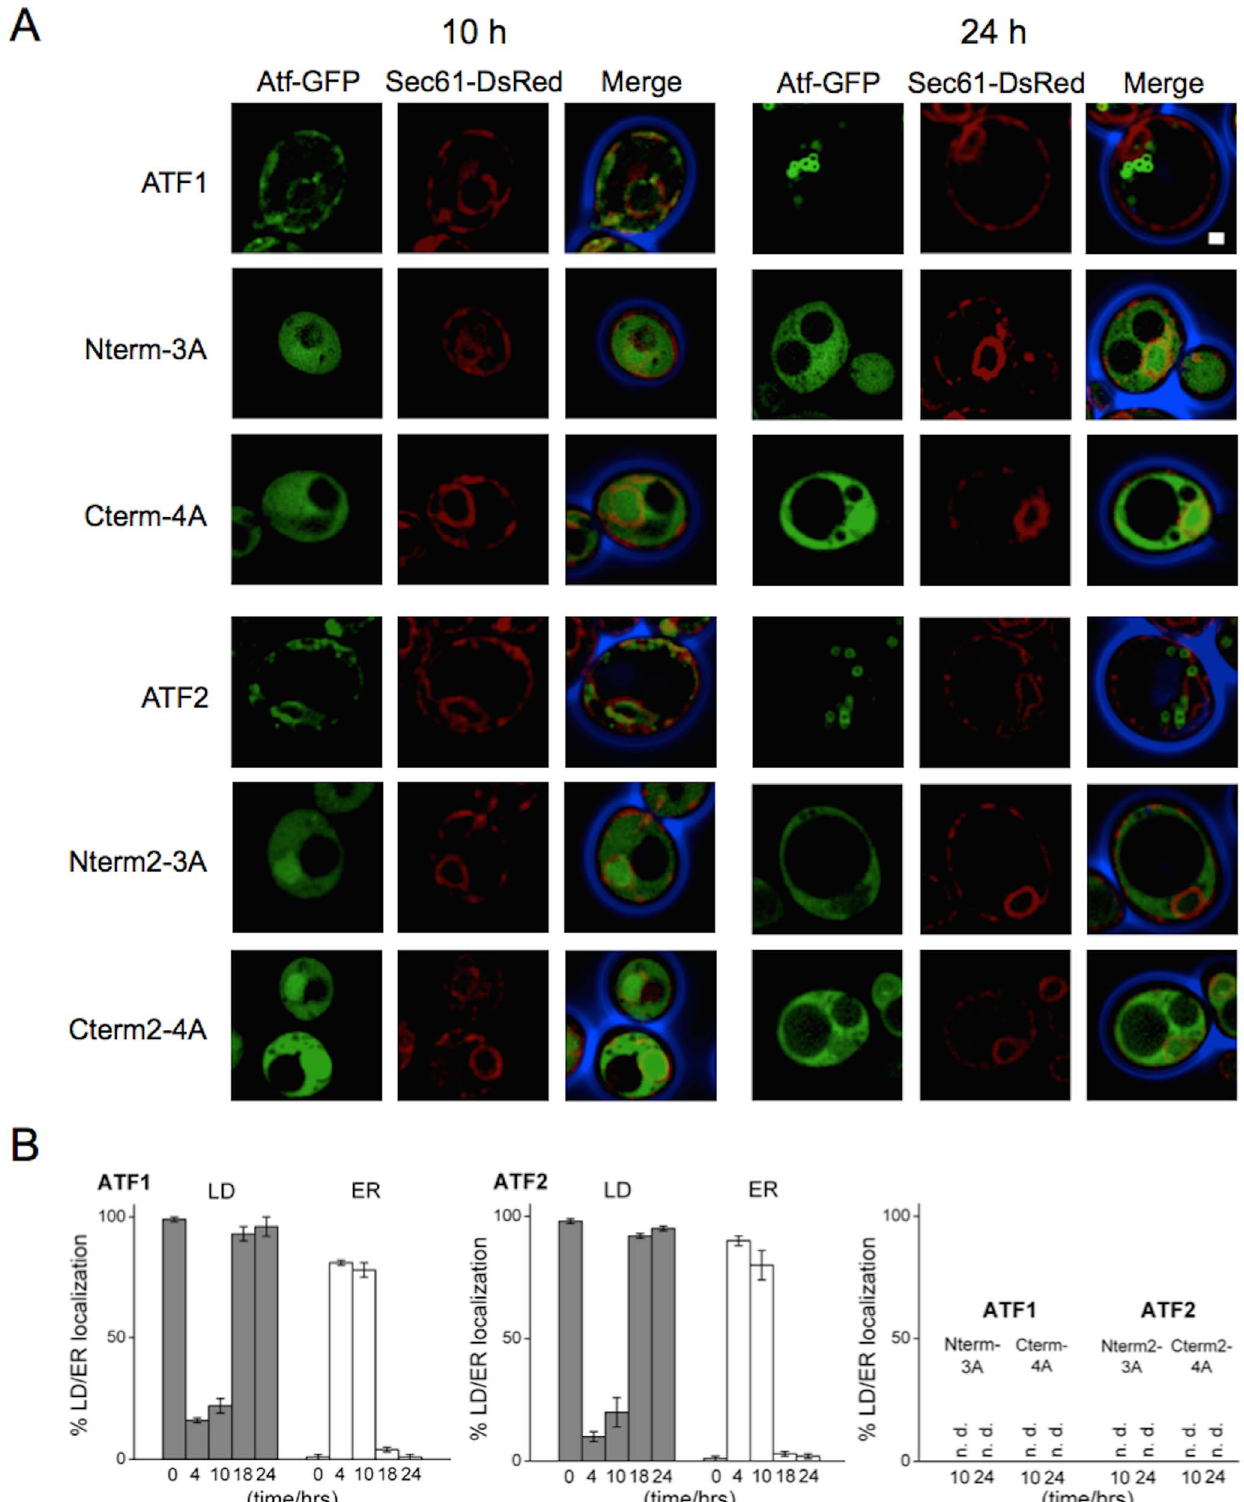
Figure 5. Atf1 and Atf2 from S.cerevisiae localize to LDs via the ER. (A) Cells overexpressing wild type and mutant Atf1 and 2 2 were cultured in synthetic uracil dropout media with 2% glucose to log phase and stationary phase and analyzed by fluorescence microscopy. The ER is identified by chromosomal tagging of the ER marker Sec61 with DsRed. Wild type Atf1 and 2 2 associate with the ER during log phase and preferentially sort to LDs during stationary phase. Disruption of the N- or C-terminal amphipathic helices in both Atf1 and 2 2 prevents ER association and subsequent localization to LDs. Scale bar, 1 m m. (B) Quantification of LD and ER localization at different time points. Data are plotted as mean 6 SD. A minimum of 300 cells were counted from three independent experiments. doi:10.1371/journal.pone.0104141.g005 PLOS ONE |